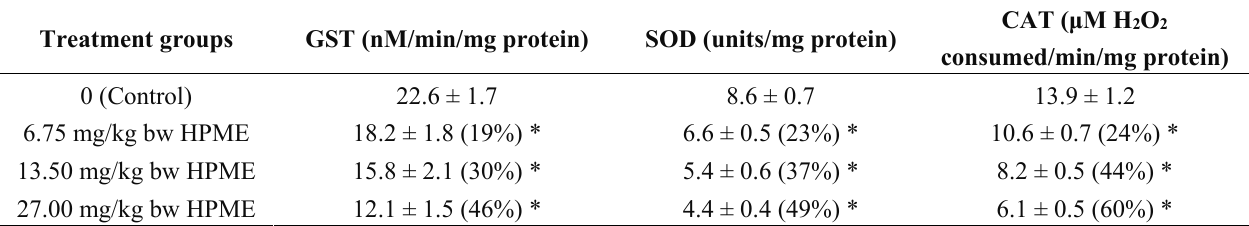
Table 4. Influence of haloxyfop- p -methyl ester on enzymatic antioxidants in the testis of rat. Treatment groups